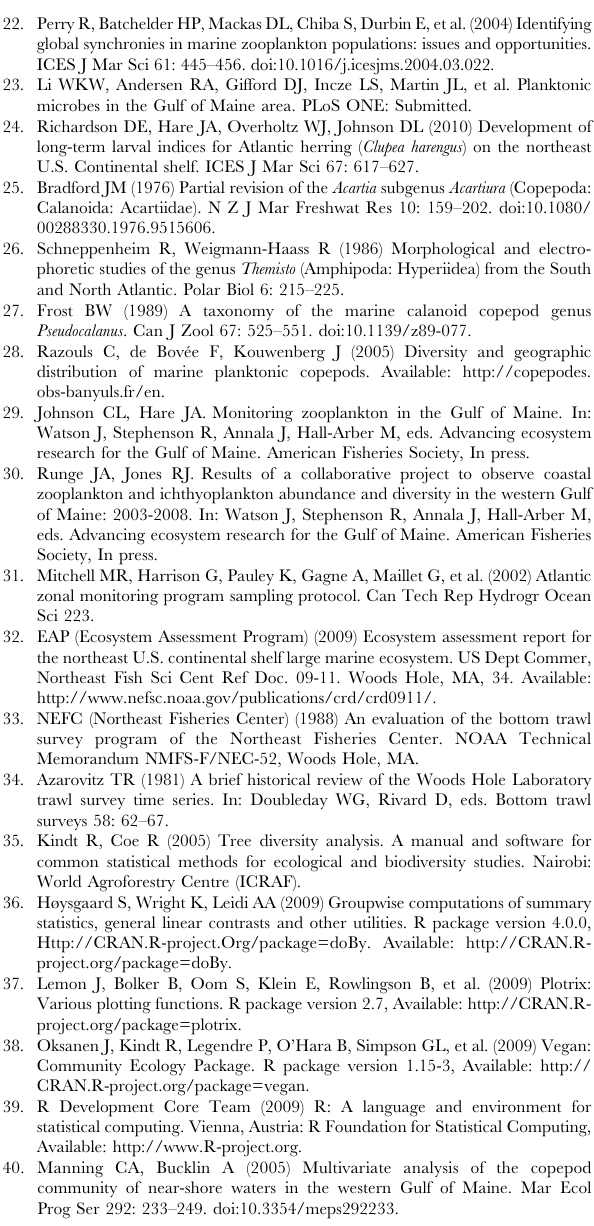
Table S1 Total metazoan diversity from the Gulf of Maine Register of Marine Species (GoMRMS) and metazoan diversity from plankton samples. Table S2 Phylogenetic list of all planktonic species listed in the plankton databases analyzed in this